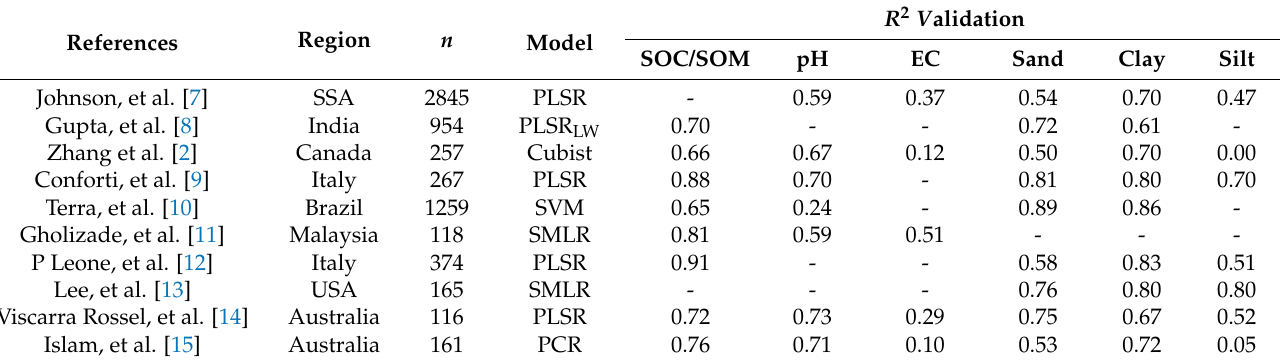
Table 1. Literature review of most commonly predicted soil properties using VIS-NIR spectroscopy with corresponding coefficient of determination (R 2 ) on validation